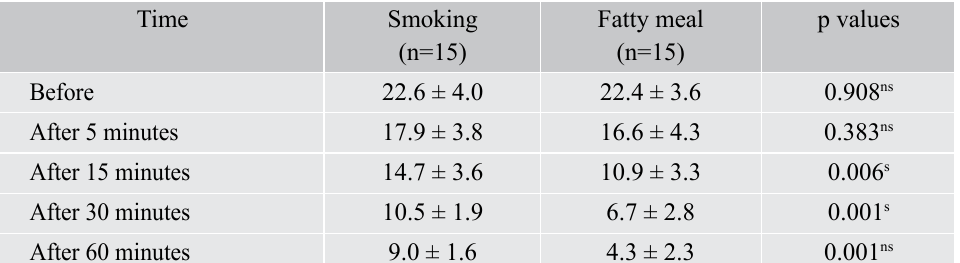
Table IV: Mean comparison of gallbladder volume (in cm 3 ) after smoking and fatty food intake in Group II